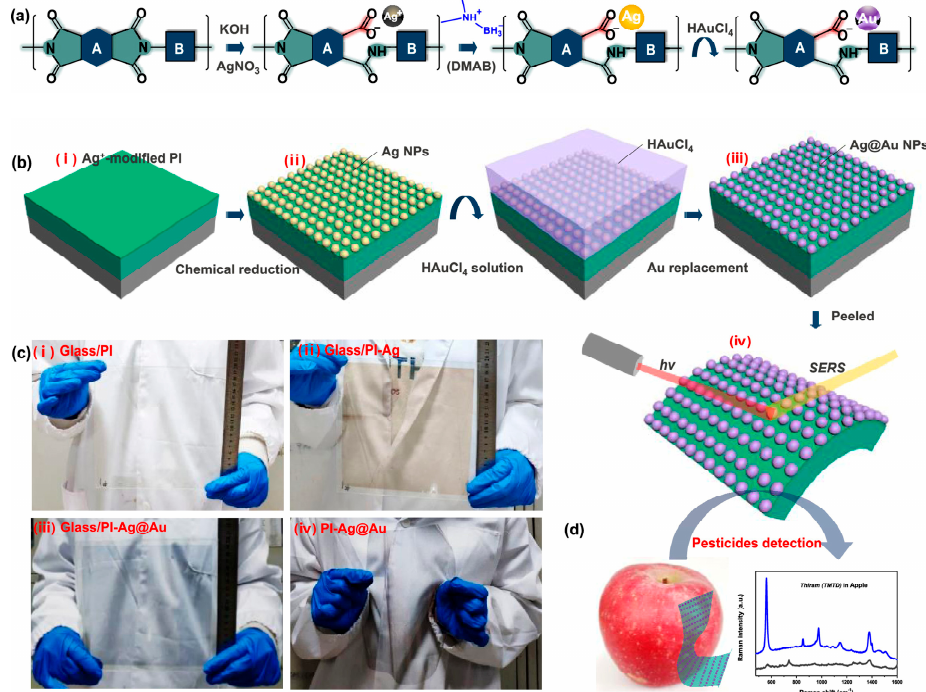
Figure 23. Schematic illustration of ( a ) Ag@Au NP growth on the CPI molecular chain and ( b ) cor- responding flexible SERS sensor. ( c ) Photographs of the fabrication process of the SERS sensor. ( d ) Diagram of direct sampling and SERS detection of pesticide on an apple. Reprinted with permis- sion from Ref. [212]. 2018, ACS